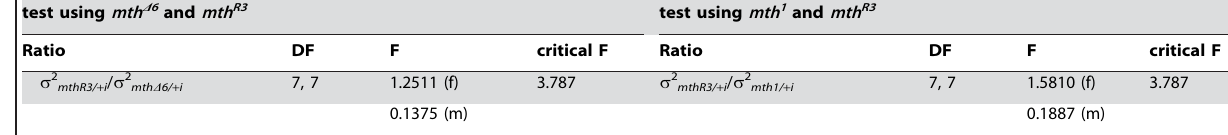
Proportionalhazardsmodeleffectlikelihoodratiotests test using mth D 6 and mth R3